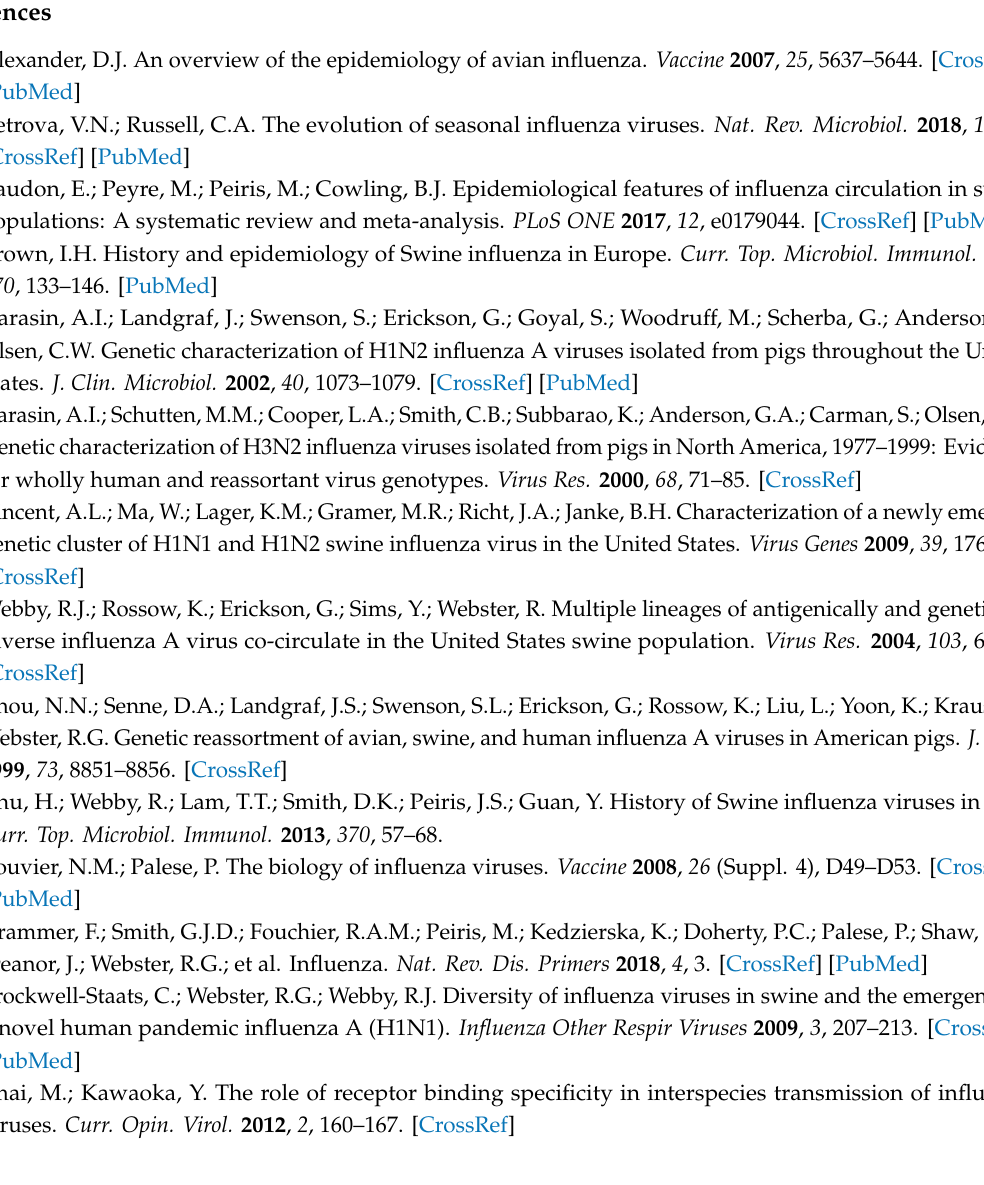
Figure S1: Phylogenetic analysis of the NA(A), PB2 (B), PB1 (C), PA (D), NP (E), M (F), and NS (G)genes, Table S1: The nucleotide homology between the AV1522 virus and the A / swine / Hubei / 02 / 2008(H1N1) virus, when analyzing each gene